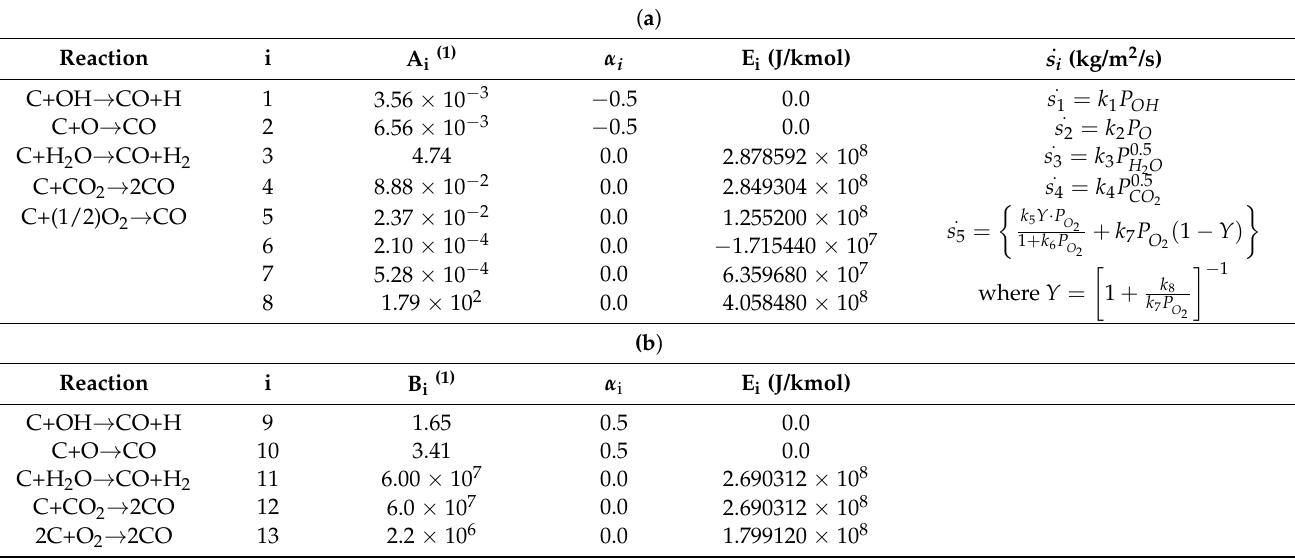
Table 1. ( a ) Heterogenous rate constants for nonporous graphite oxidation (from Chelliah [30]). ( b ) Heterogenous rate constants for porous graphite oxidation (from Chelliah [30]). Here,